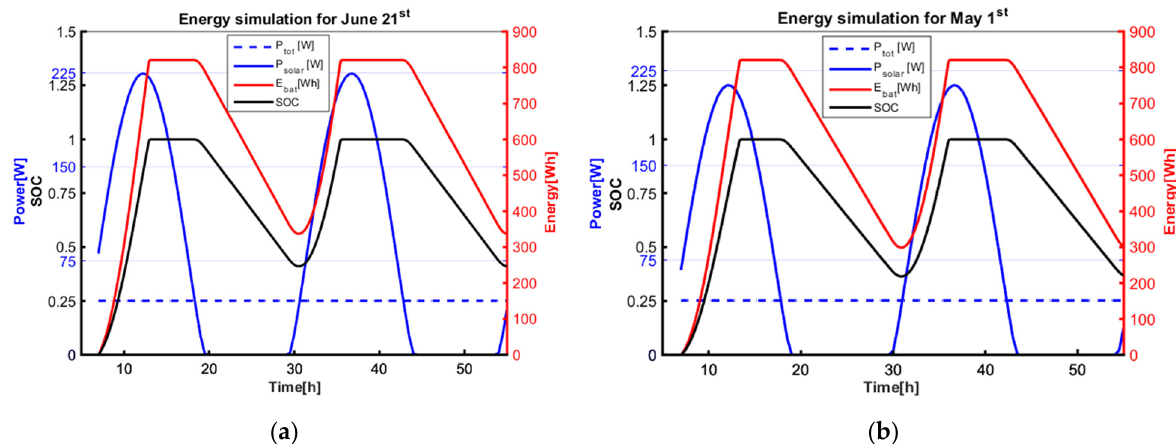
Figure 10. Performance comparison of airfoils.